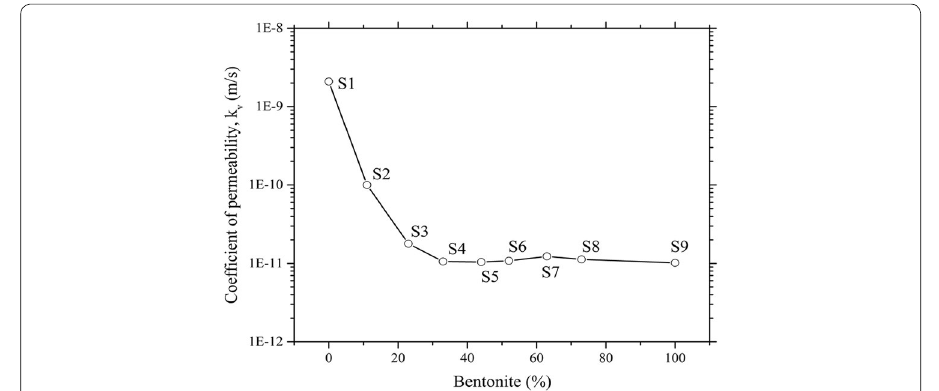
Fig. 10 Variation of coefficient of permeability k v with bentonite